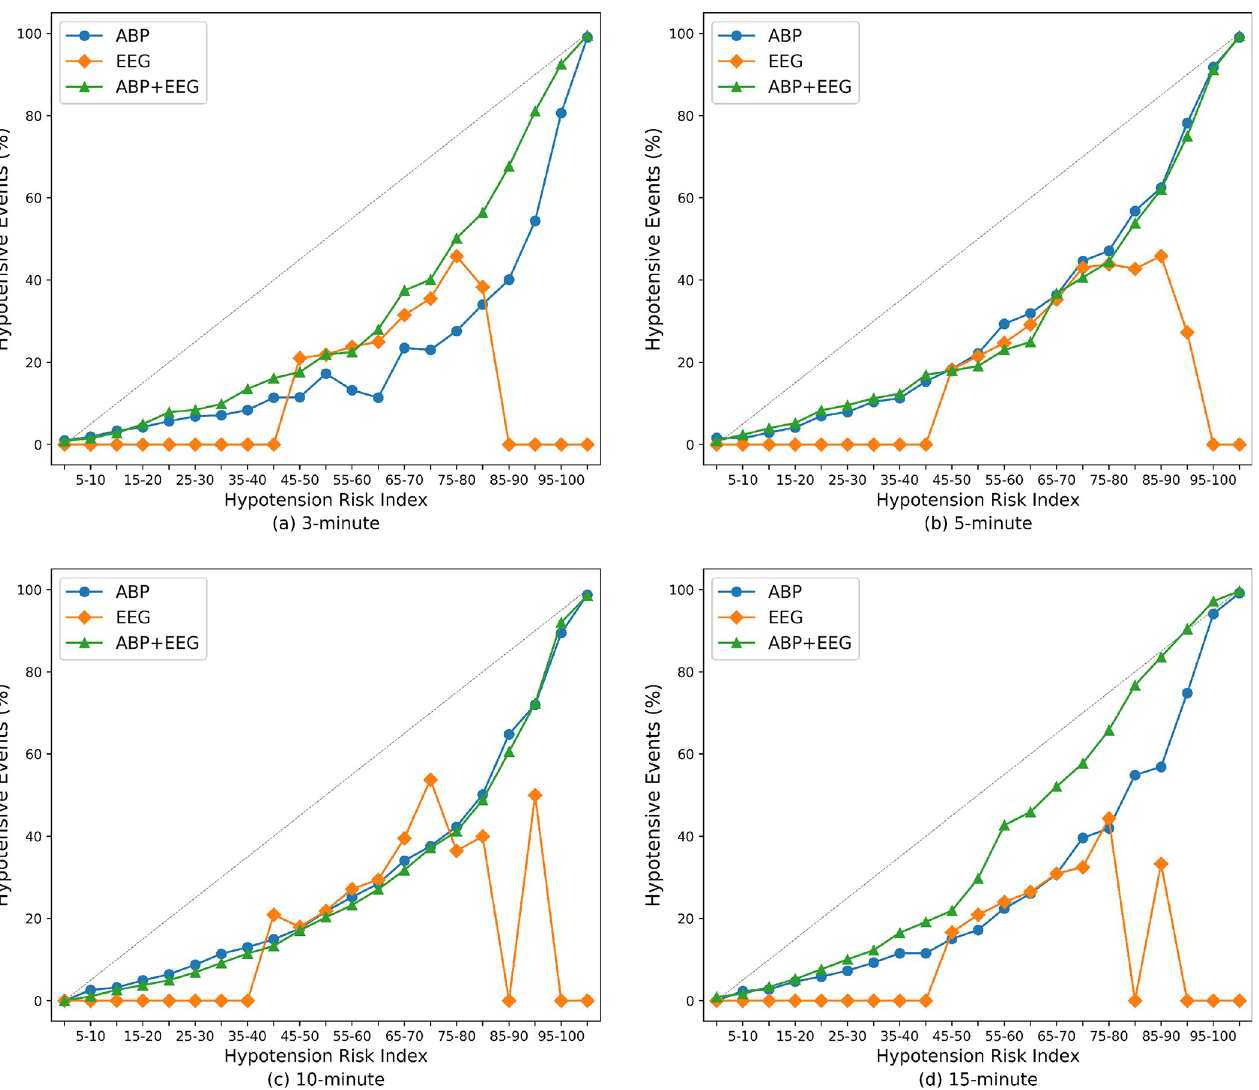
Fig 4. Actual occurrence of hypotensive events according to the Hypotension Risk Index. (a–d) Actual occurrence of hypotensive events according to the hypotension risk indices to predict the events 3, 5, 10, and 15 min before, respectively. ABP, arterial blood pressure; EEG,